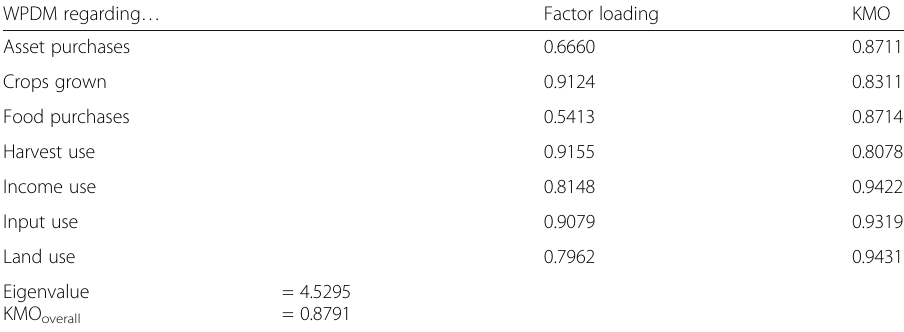
Table 3 Factor loadings and KMO values of WPDM variables WPDM regarding